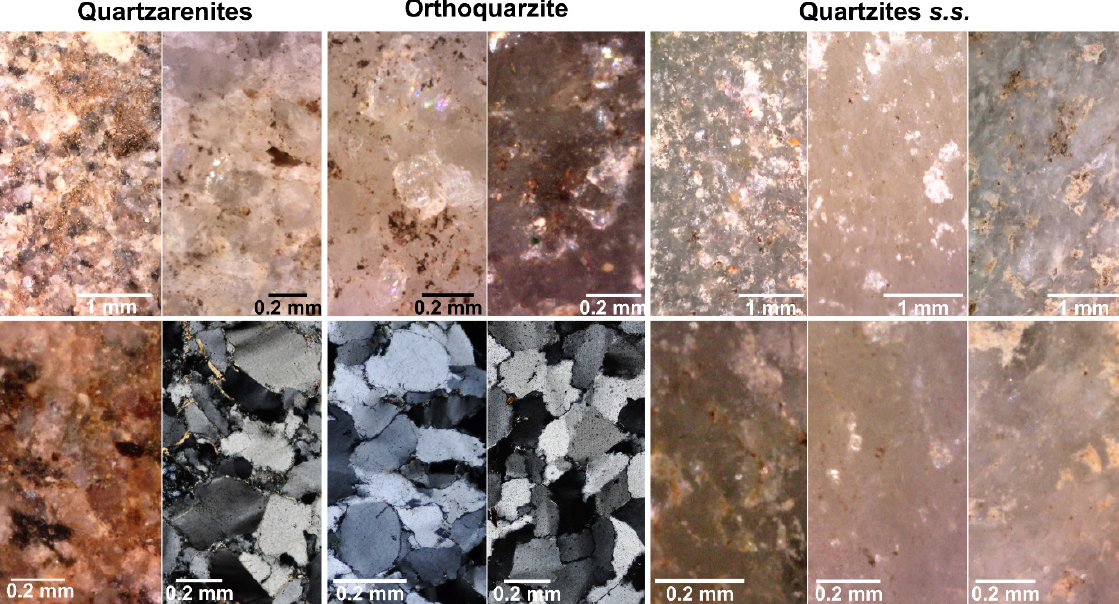
Figure 5. Photomicrographs of quartzite surfaces and thin sections at different magnifications for the seven quartzite types at El Esquilleu Level XXII-R: From left to right: ES-318, an MA type; ES-263, a CA type; ES- 245, a OO type; ES-246, an SO type; ES-331, an BQ type; ES-R242, an RQ type; ES-R093, an MQ